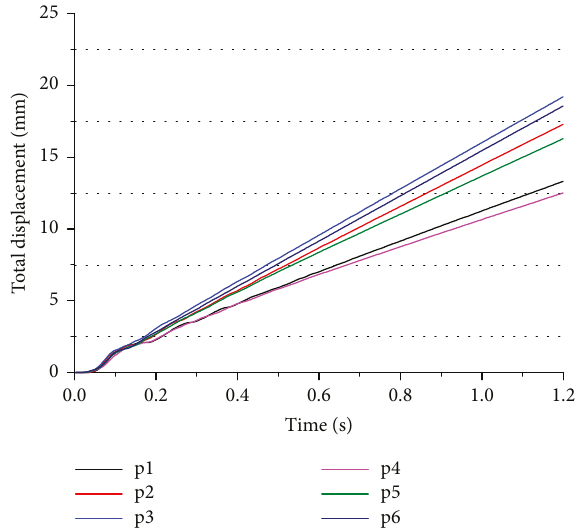
Figure 33: Time-history response curve of velocity at characteristic points on the embankment in the fourth excavation.